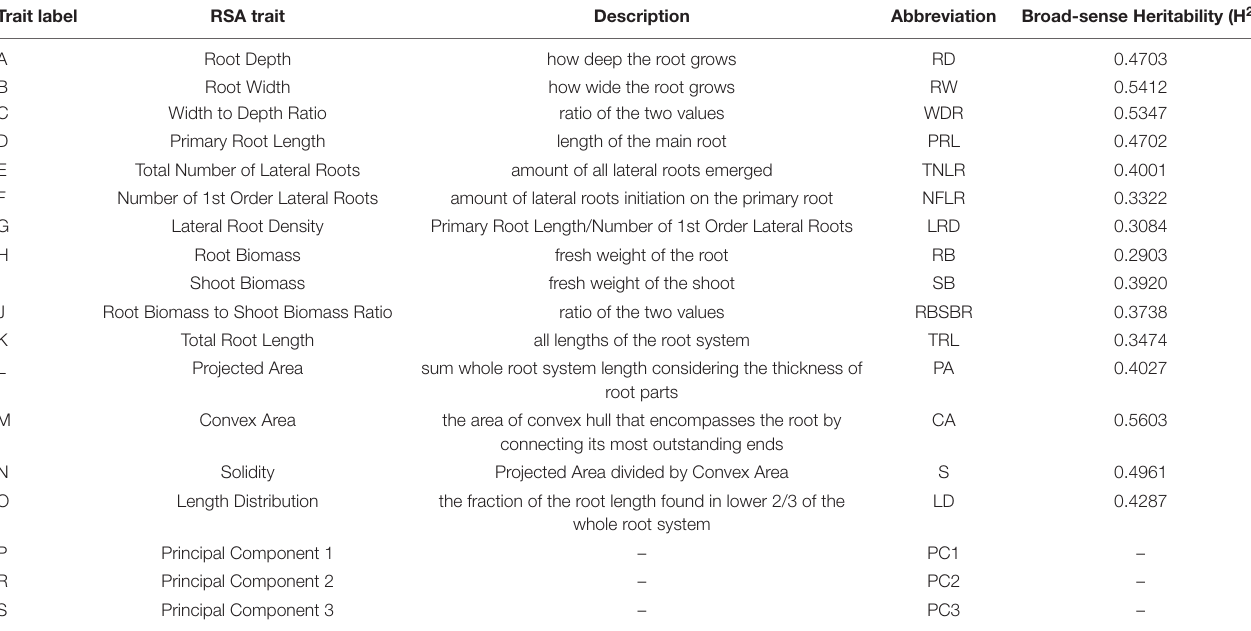
TABLE 1 | Root system architecture (RSA) traits measured on 241 Arabidopsis thaliana accessions and broad-sense heritability values (H 2 ) measured for 15 RSA traits. Trait